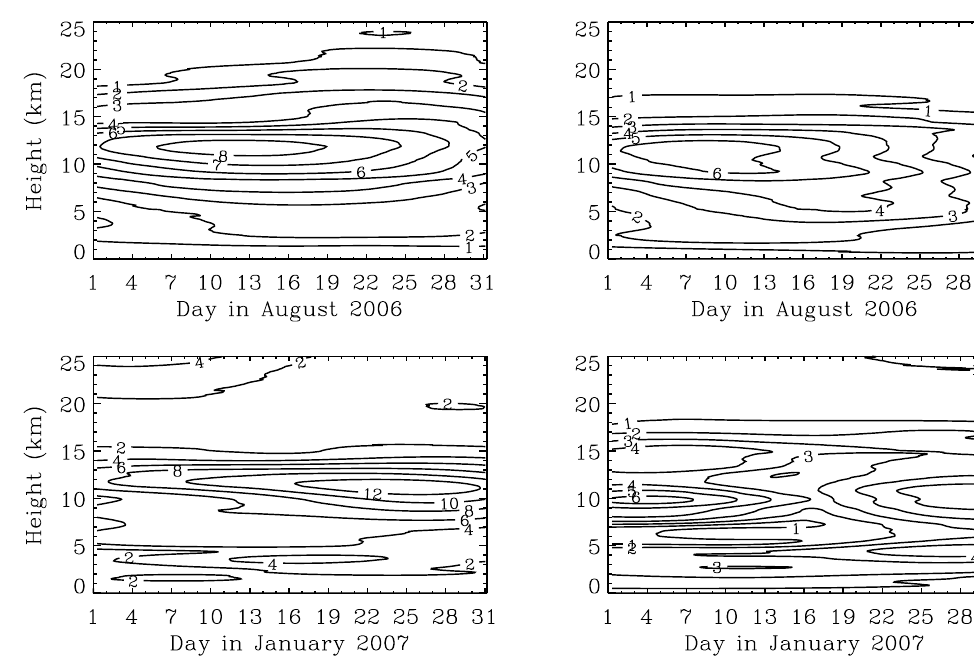
(antinodes) are both spaced a half vertical wavelength